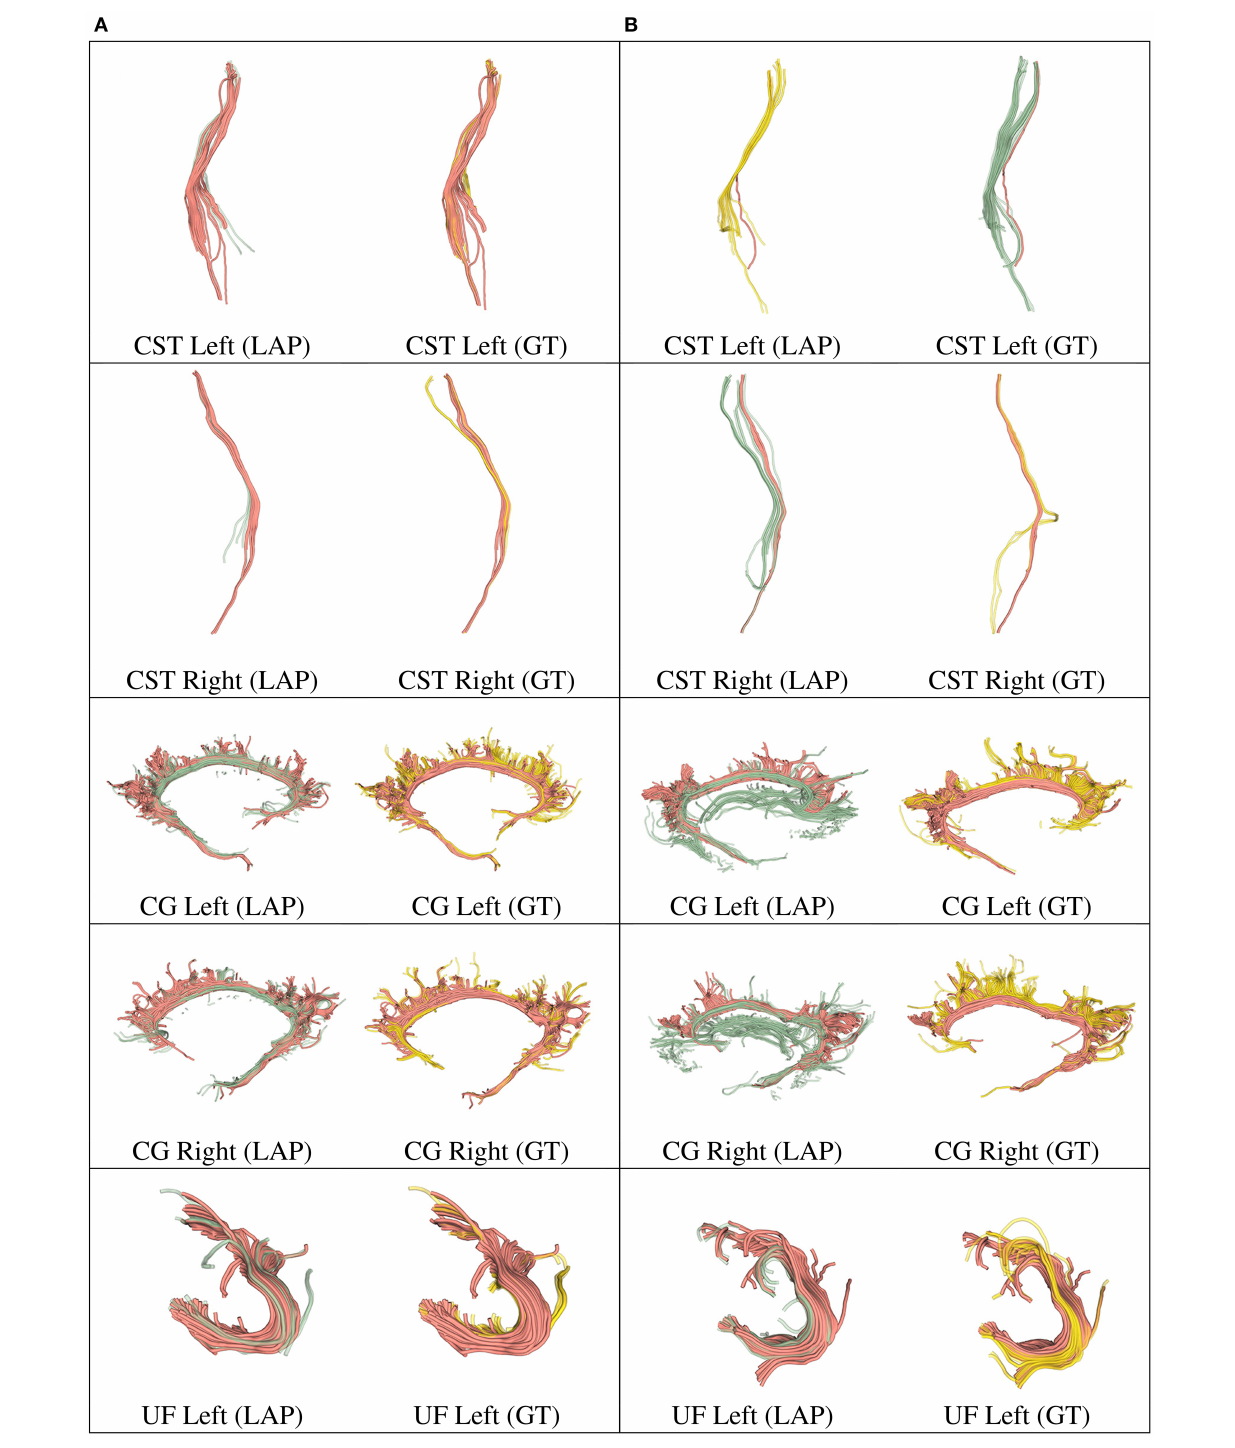
Frontiers in Neuroscience |